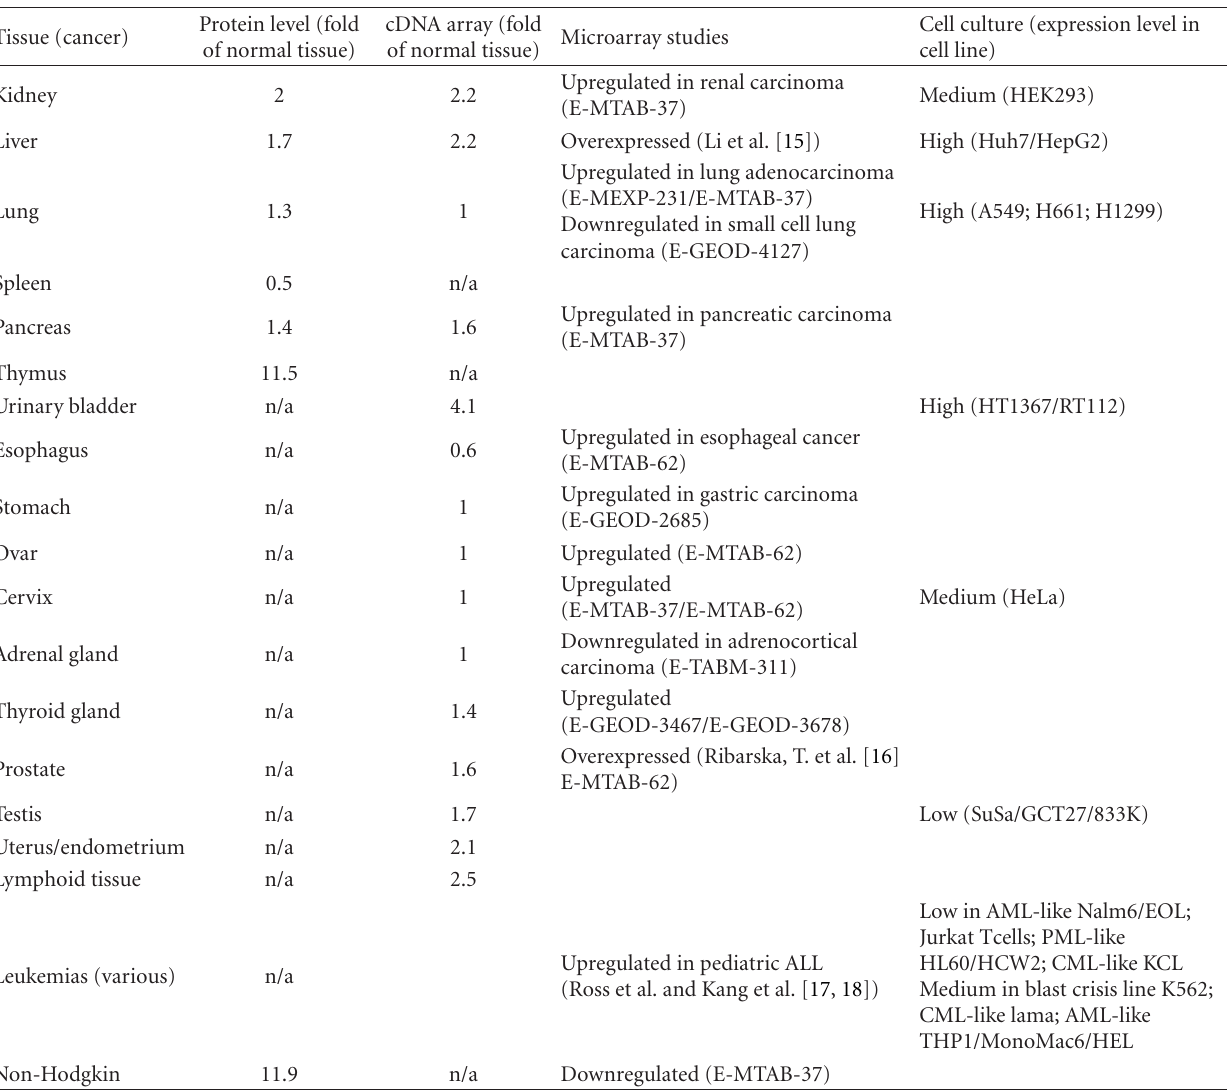
Table 1: Expression levels of PON2 in various tumor tissues and/or cancer cell cultures. Microarray experiment (array express) listings are according to the Gene Atlas Database. Protein and cDNA levels according to [23]. Cell culture expression levels were roughly estimated as relative level comparing to A549, grouped into low, medium, or high